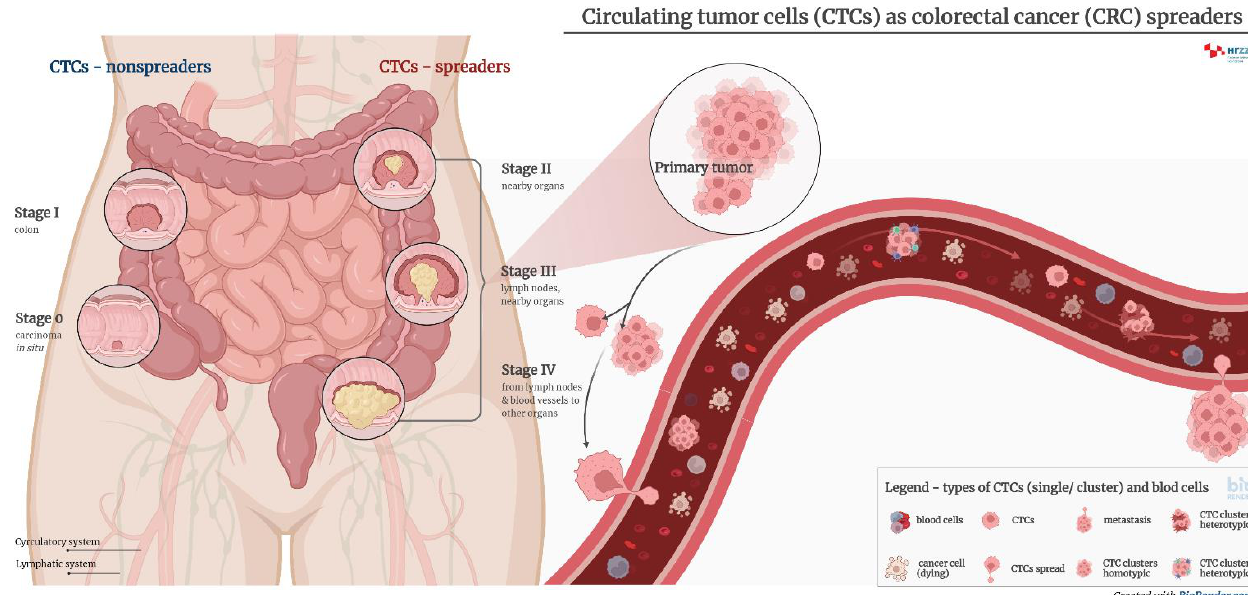
Figure 1. The roles of CTCs in tumor metastasis. Circulating tumor cells (CTCs) originating from primary or secondary tumors contain important information on the molecular characteristics relevant to tumor progression and therapy. CTCs can appear either as single cells or clusters, which have an increased metastatic potential and a shorter half-life. Their metastatic potential further depends on the specific microenvironment and local vasculature. CTC clusters may be further divided into two main types — homotypic and heterotypic.